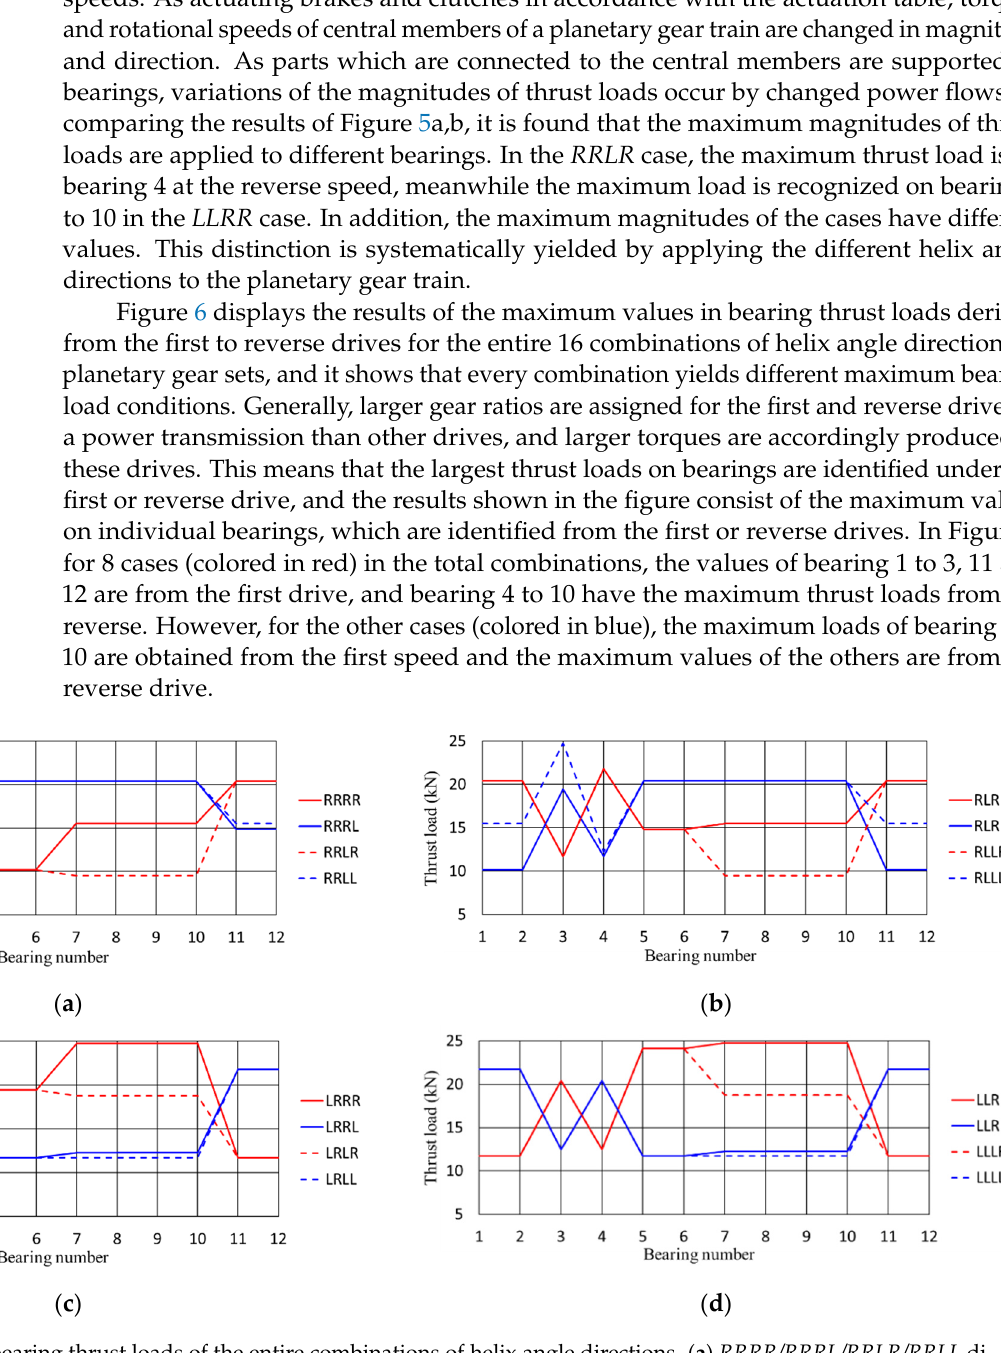
Figure 6. Maximum bearing thrust loads of the entire combinations of helix angle directions. ( a ) RRRR/RRRL/RRLR/RRLL directions; ( b ) RLRR/RLRL/RLLR/RLLL directions; ( c ) LRRR/LRRL/LRLR/LRLL directions; ( d ) LLRR/LLRL/LLLR/LLLL di- rections.